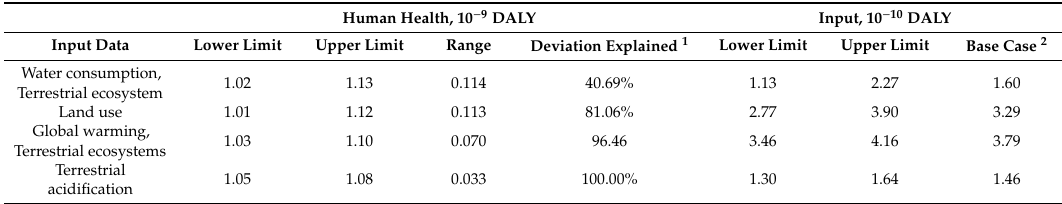
Table 7. Results of the MC simulation performed in CB for the tornado-type sensitivity analysis of the significant categories of impact on ecosystem quality.